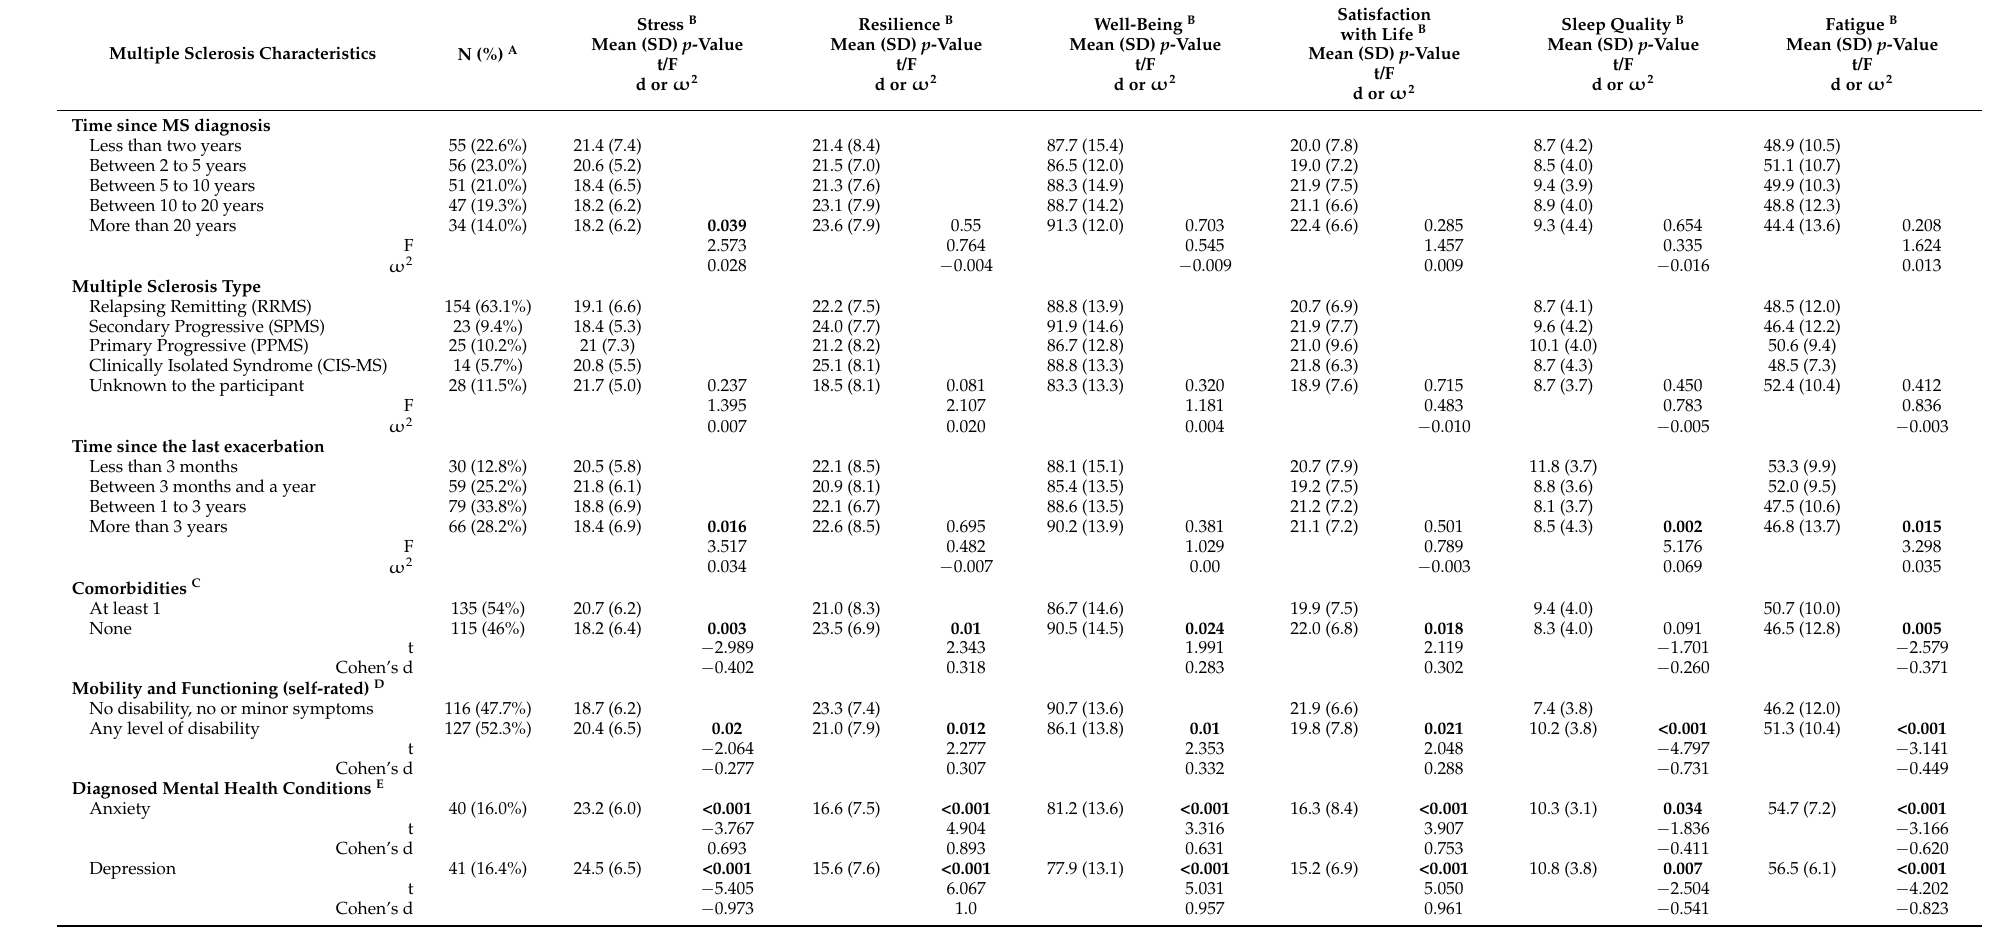
Table 3. Disease-related characteristics in relation to the dependent